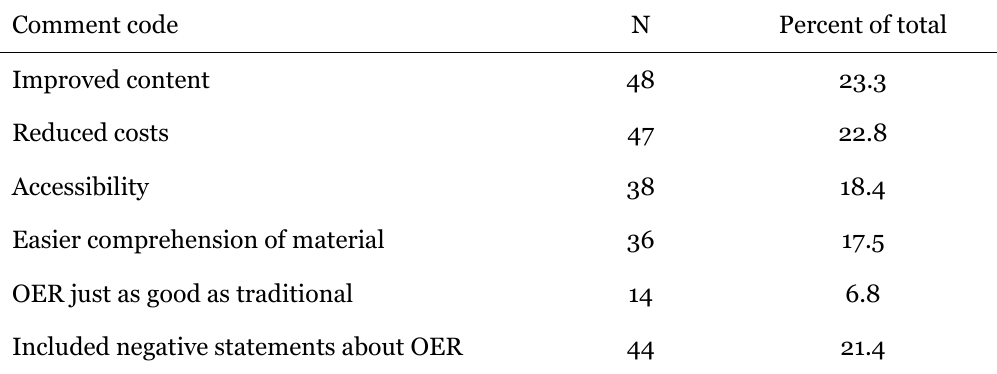
Number of Comments Coded, by Category, from Student Perception of OER